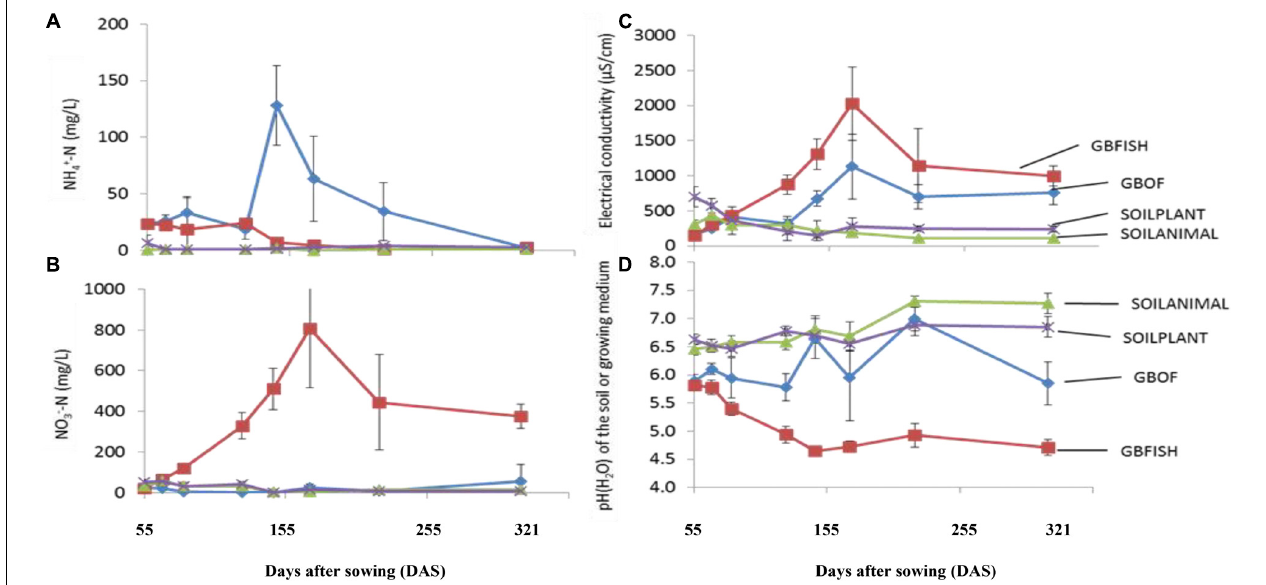
FIGURE 3 | Evolution of the ammonium concentration (A) . Nitrate concentration (B) . The electrical conductivity (C) and pH(H 2 O) (D) in the growing medium. i.e., GBOF and GBFISH and the organic soil. i.e., SOILANIMAL and SOILPLANT during the whole experimental period which lasted 321 days. The ammonium and the nitrogen content, the pH and the electrical conductivity (EC) in the 0–10 cm organic soil layer and in the growing medium were taken at the start 55 DAS (T0), 68 DAS (T1), 83 DAS (T2), 113 DAS (T3), 146 DAS (T4), 172 DAS (T5), 221 DAS (T6), and 321 DAS (T7). TABLE 2 | Average values of 11 different variables throughout the whole experimental period with standard error. Variable Treatment (trt) p -value (trt) p -value (time) GBOF GBFISH SOILANIMAL